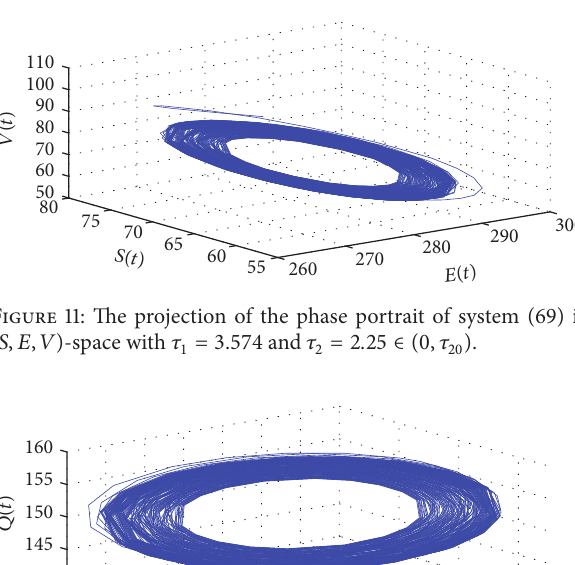
Figure 8: The projection of the phase portrait of system (69) in (𝐼, 𝑄, 𝑅) -space with 𝜏